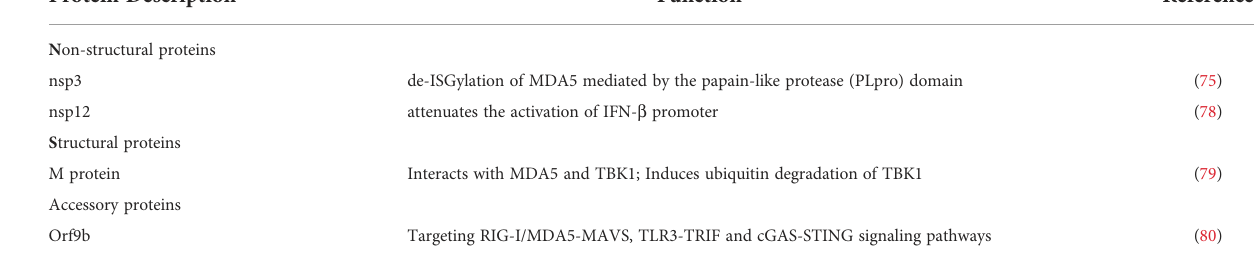
TABLE 1 SARS-CoV-2 proteins involved in MDA5 mediated antiviral immunity. Protein